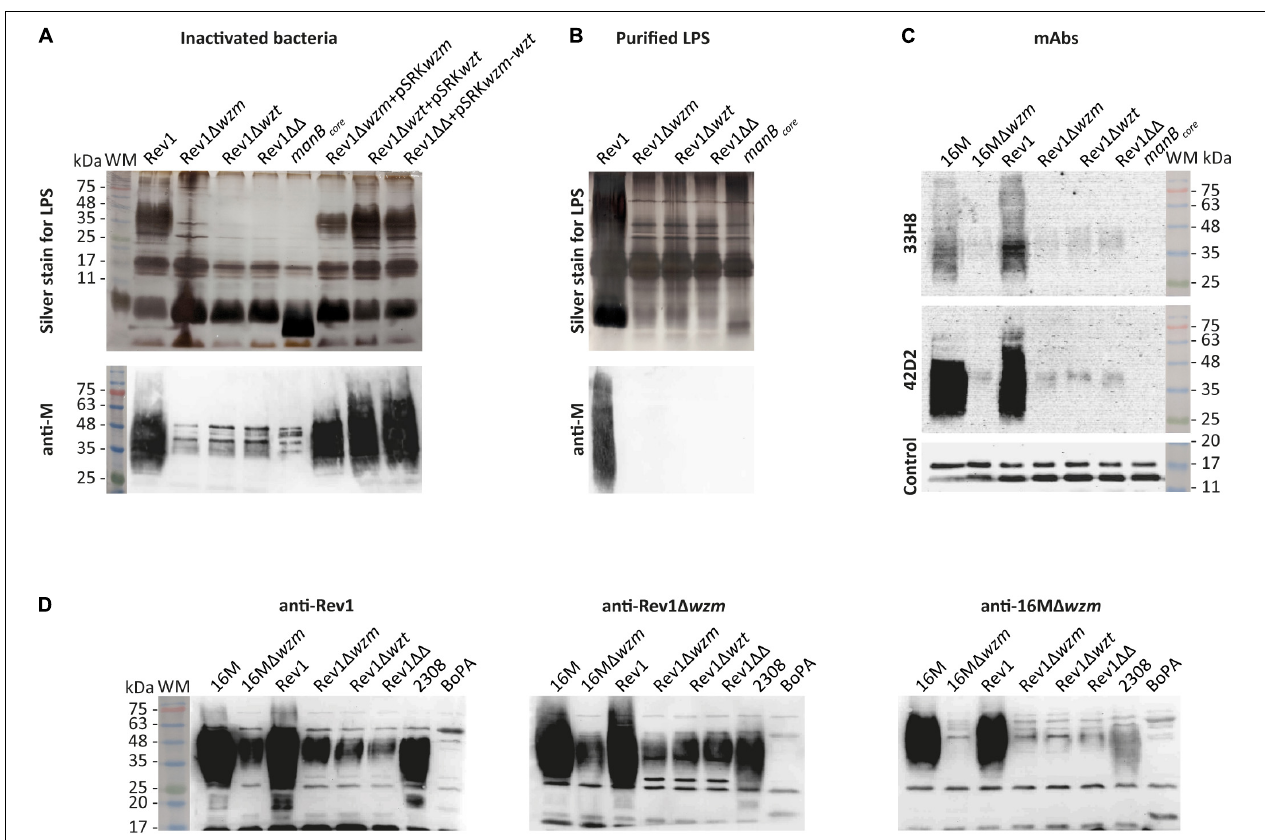
FIGURE 2 | Rev1 wzm / wzt mutants express R-LPS with a complete core and a cytoplasmic O-PS reacting with mAbs. (A) Whole-cell phenol-inactivated bacteria or (B) purified LPS profiles detected by modified periodate-alkaline silver staining (upper panels) or by WB with anti-M monospecific serum (lower panels). (C) O-PS epitopes of whole bacteria recognized by the mAbs 33H8 for 20 min of exposure (the upper panel) or 42D2 for 6 min (the middle panel); anti- B. ovis serum was run as loading control on the same 42D2 blot (the lower panel). (D) Western blot with anti-Rev1, anti-Rev1 (cid:49) wzm , or anti-16M (cid:49) wzm immune sheep sera. The images presented in the same groups were processed in parallel, and the results are representative of reproducible experiments. WM, pre-stained weight Marker VI (PanReac AppliChem, Castellar del Vallés, Barcelona,